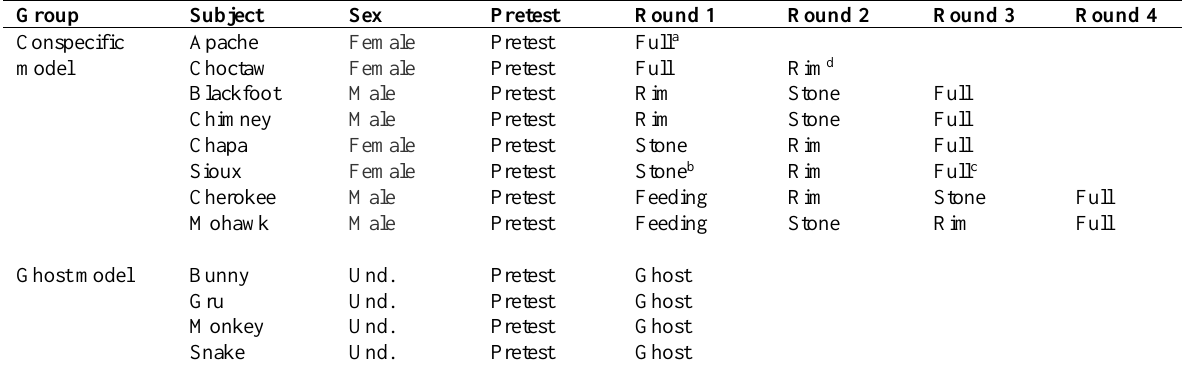
An overview of the Test Groups and the order of Experimental Conditions